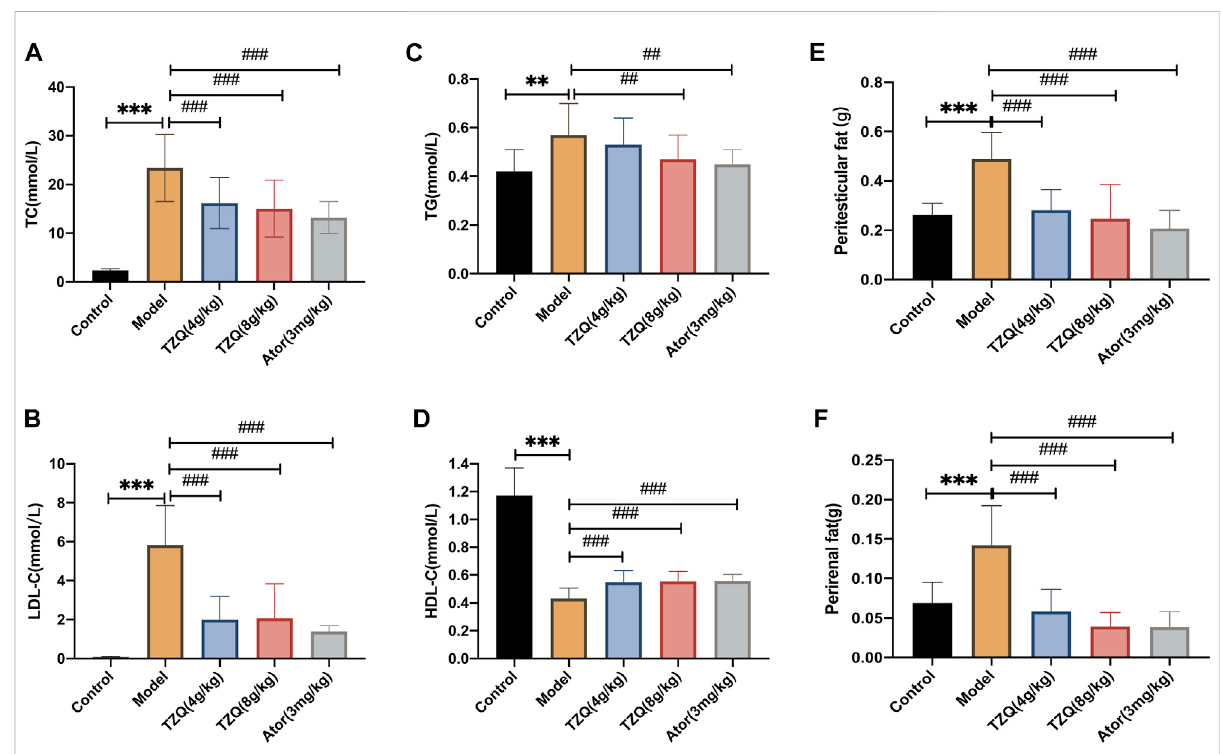
FIGURE 2 Effect of Tangzhiqing (TZQ) on lipid metabolism. (A) : TC. (B) : LDL-C. (C) : TG. (D) : HDL-C. (E) : Peritesticular fat. (F) : Perirenal fat. n = 13 mice for each group, ** p < 0.05, *** p < 0.01 versus Control, ## p < 0.05, ### p < 0.01 versus